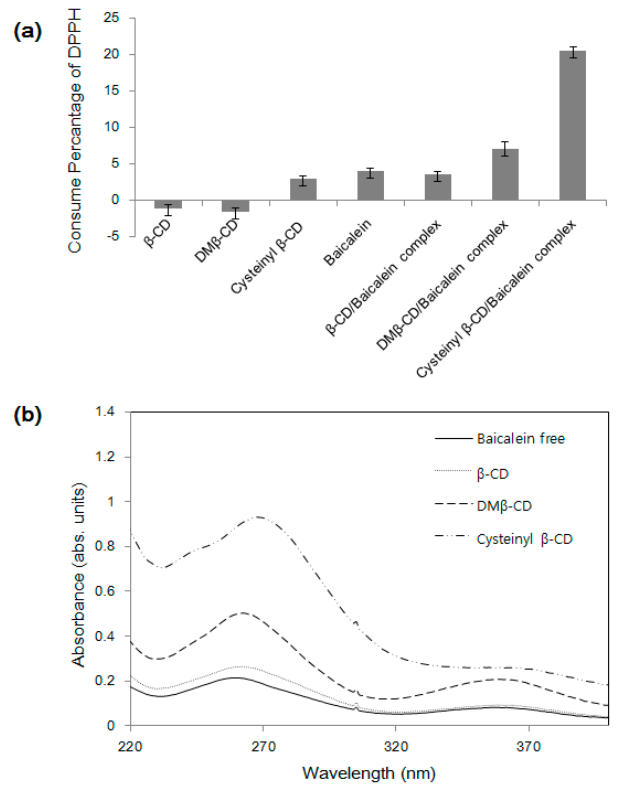
Figure 8. ( a ) Consumption of DPPH in the presence of baicalein, β -CDs and their complexes; ( b ) Absorption spectra of baicalein in aqueous solution with different β -CDs.